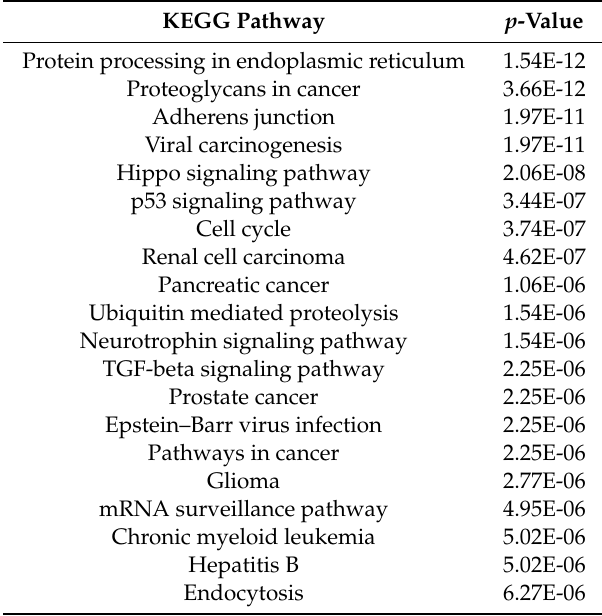
Table 2. Twenty most significant KEGG